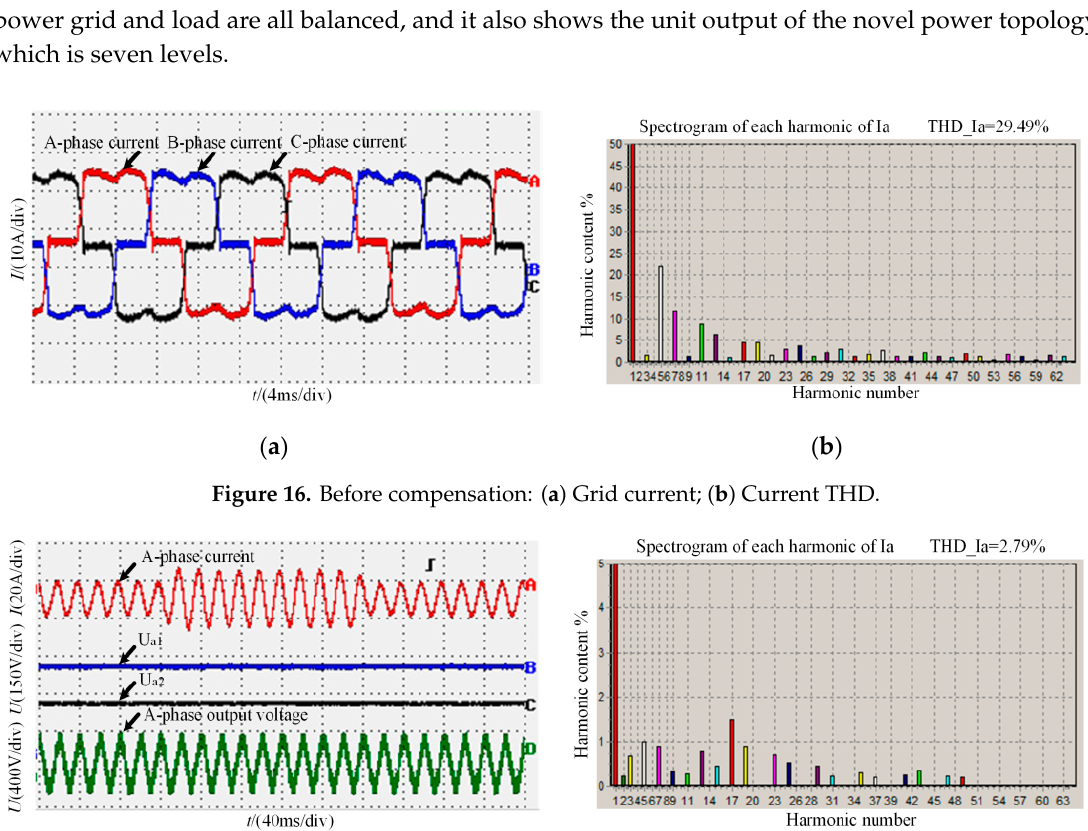
Figure 18. Before compensation: ( a ) Grid current; ( b ) Current THD.